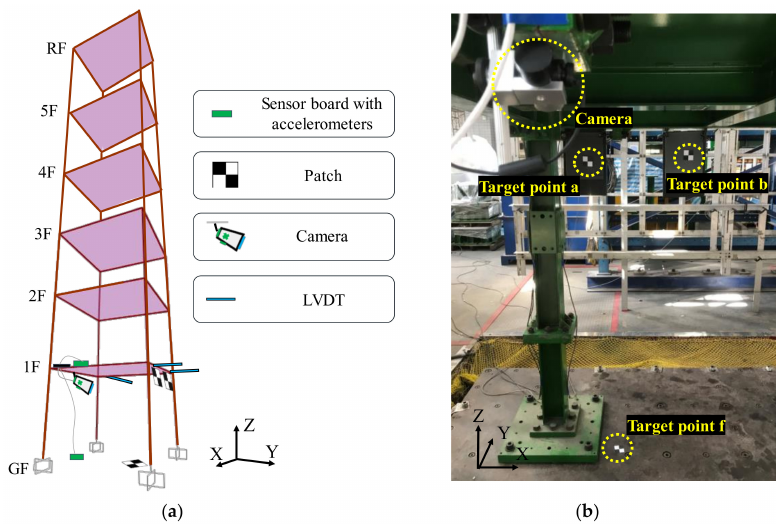
Figure 9. ( a ) Schematic diagram indicating the locations of the target patches, the linear variable di ff erential transformers (LVDTs), and the components of the smart camera system installed in the first story; and ( b ) the target points and the